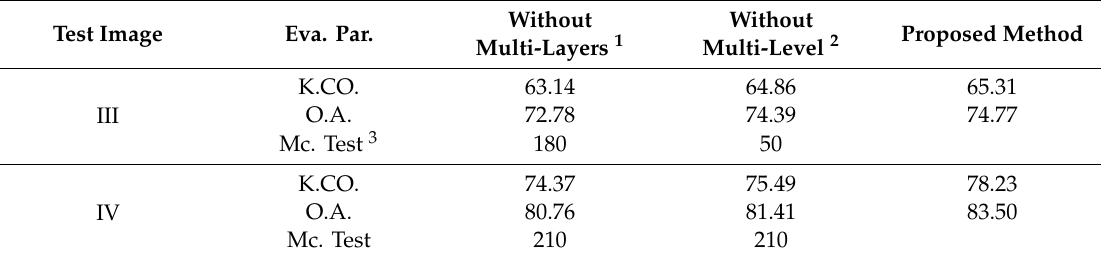
Table 5. Internal evaluation of the proposed method in terms of the type of features used. Test Image